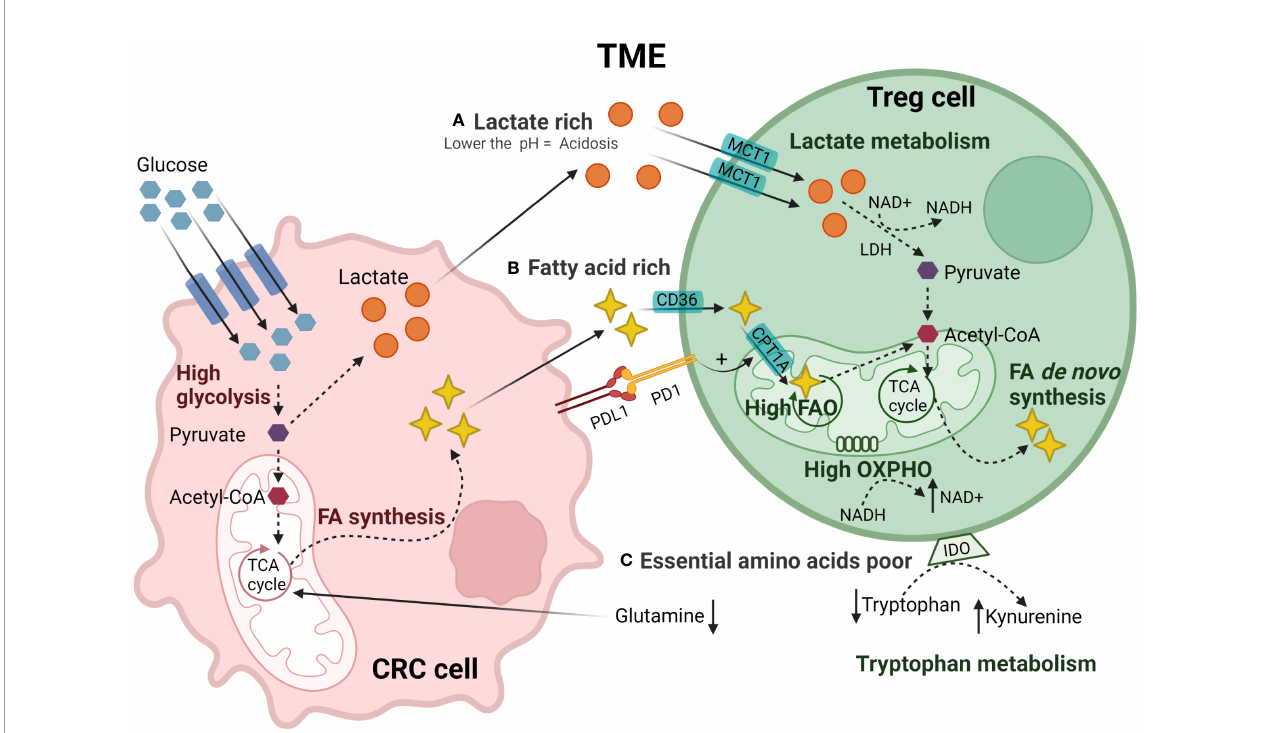
FIGURE 2 | Metabolic reprogramming of TI-Treg cells in CRC TME. CRC tumor cells have a high glucose uptake generating pyruvate through glycolysis. Pyruvate is converted to acetyl-CoA or lactate that is secreted creating (A) a lactate-rich TME. TI-Treg cells adapt to these metabolic stresses present in the TME. TI-Treg cells can take up lactate through the MCT1 transporter that is subsequently converted to pyruvate by LDH and further to acetyl-CoA. Moreover, CRC tumor cells fuel the tri-carboxylic acid (TCA) cycle in the mitochondria for FA synthesis creating a (B) fatty acid-rich TME. TI-Treg cells can take up FA from the TME through the fatty acid transporter CD36. The CPTR1A transporter drives FA uptake into the mitochondria where it is oxidized by fatty acid oxidation (FAO) to acetyl-CoA. Acetyl-CoA fuels the TCA cycle in the mitochondria for de novo fatty acid synthesis that can be accumulated intracellularly or exported to the TME. The TME has (C) low availability of essential amino acids, particularly glutamine, that is consumed by tumor cells, and tryptophan, that is catabolized to kynurenine by IDO highly expressed by Treg